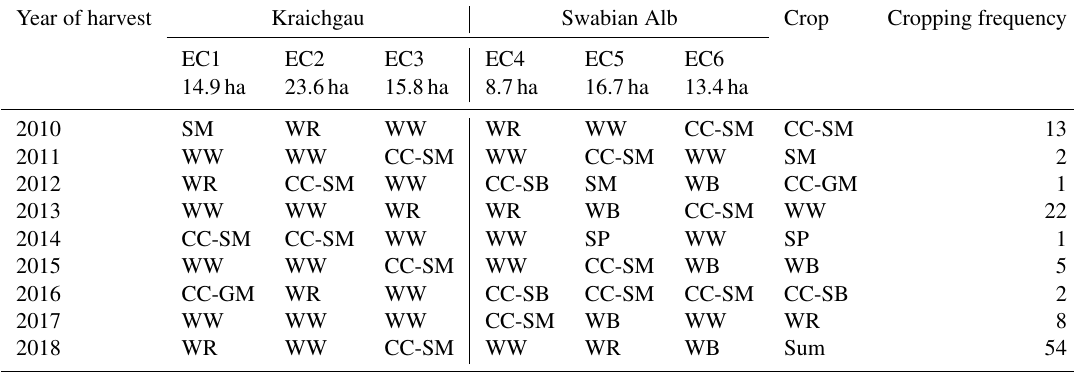
Table 2. Research sites EC1 to EC6 and land use from 2010 to 2018. Year of